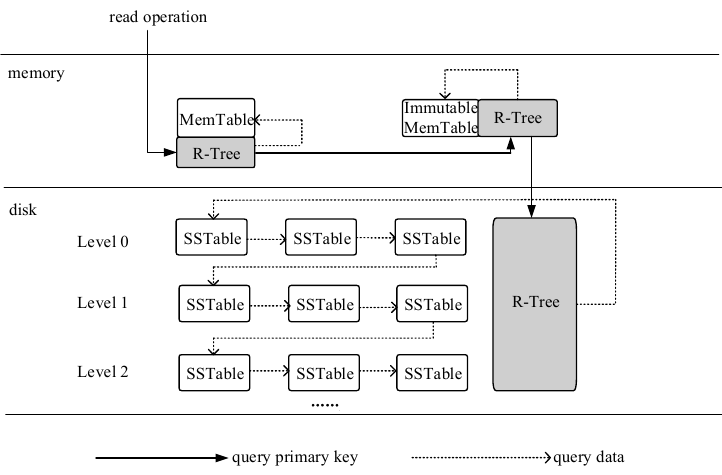
Figure 7. Stand-alone R-tree index query flow. Based on the above ER-tree index, this paper proposes point query, rectangular range query and circle range query algorithms for spatial data on the ER-tree